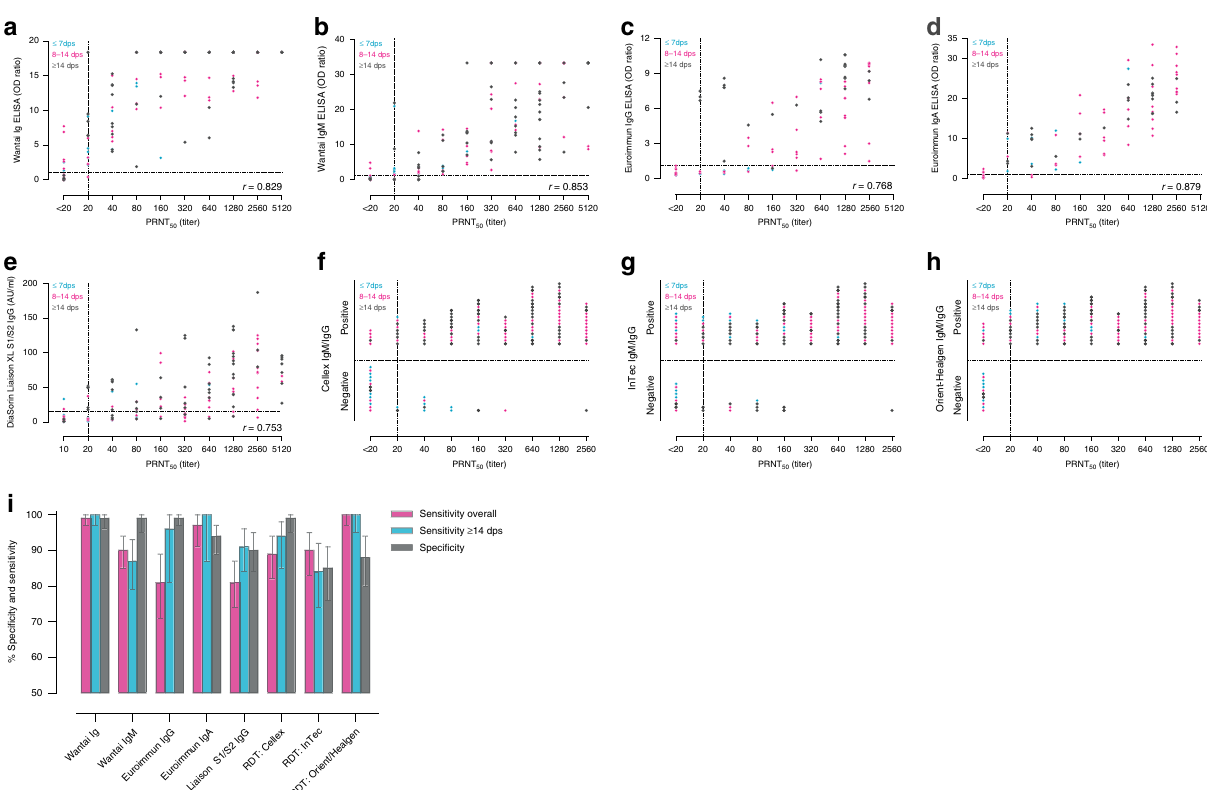
Fig. 1 Performance of commercial assays for the detection of SARS-CoV-2-speci fi c antibodies. Correlation of SARS-CoV-2 neutralizing antibody titers tested by a plaque reduction neutralization assay (PRNT50) to antibodies measured by selected assays. ( a ) Wantai Ig total ELISA, ( b ) Wantai IgM ELISA, ( c ) Euroimmun IgG ELISA, ( d ) Euroimmun IgA ELISA, ( e ) DiaSorin Liaison XL IgG chemiluminescence immunoassay, ( f ) Cellex IgM/IgG, ( g ) InTec IgM/ IgG, ( h ) Orient gene/Healgen IgM/IgG. Turquoise dots indicate patient specimen collected ≤ 7 days post onset of symptoms (dps), magenta dots indicate samples collected from 8 – 14 dps, gray dots indicate specimen collected more than 14 dps. Dotted lines indicate the cut-off for positivity of each assay, as indicated by the manufacturer: Wantai ELISAs, OD ratio > 1; Euroimmun ELISAs, OD ratio > 1.1; DiaSorin Liaison IgG >15 AU/ml. OD: optical density, AU: arbitrary units, r: correlation coef fi cient. ( i ) Percentages of speci fi cities and sensitivities of the various platforms tested. The arrow bar indicates the upper and lower limit of the 95% CI. Source data are provided as a Source Data fi